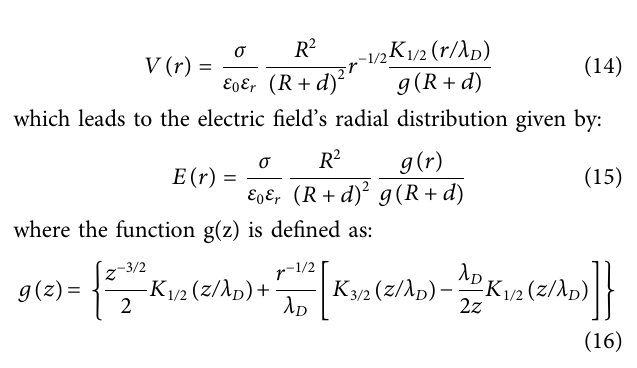
FIGURE 3 | (A) EZ from tubulin sheet. (B) Electrostatic potential energy variation. The blue and red lines refer to [KCl] = 10 mM, r (0) = R + d and r (0) = R+a, respectively.Theyellowandvioletlinesreferto[KCl]=160 mM,r(0)=R+dandr(0)=R+a,respectively.NotethatfortheEZtheblueandtheyellowlinesaremaskedby the red and violet one because processes times are almost